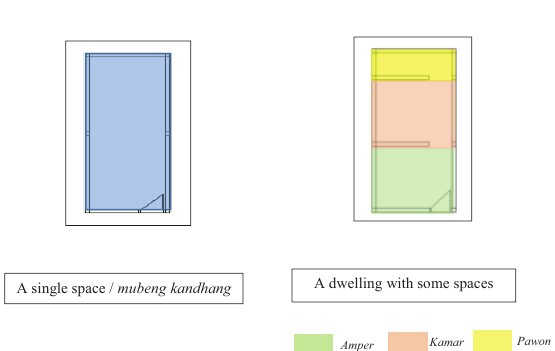
Figure 3. The personal space and space character of the dwelling